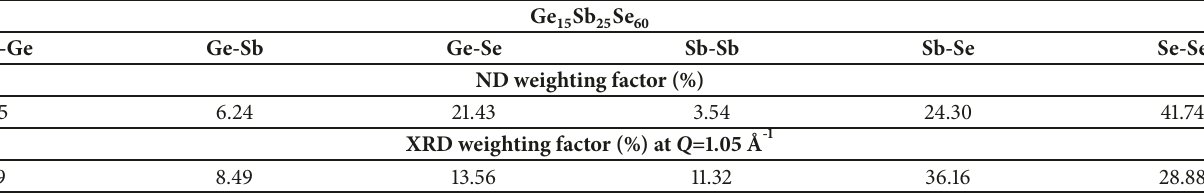
1 , of the partial atomic pairs in Ge 15 Sb 25 Se 60 sample.